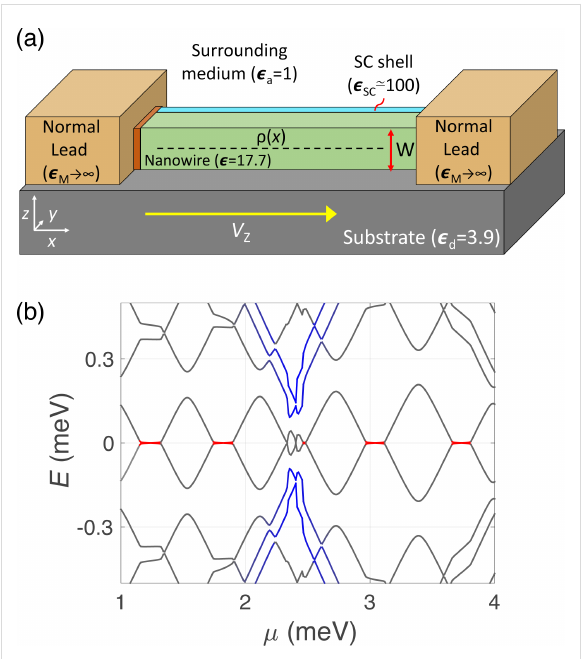
Figure 1: (a) Schematic representation of the setup analyzed in the present work. A nanowire of rectangular cross section (green) lying on an insulating substrate (grey) and in contact to a thin metallic layer in one of its faces (light blue), corresponding to the parent supercon- ductor, and two normal metal leads at its ends (orange) separated by tunnel barriers (brown). Typical values for the dielectric constants for each region are indicated. (b) Low-energy spectrum as a function of the chemical potential μ for a wire of thickness W = 100 nm and length L = 1 μ m. Other parameters are the spin–orbit coupling α = 20 nm·meV, the induced pairing energy Δ = 0.3 meV and the Zeeman energy V Z = 2 meV. Electrostatic environment-induced zero- energy pinned regions between Majorana oscillations are indicated in red. Quantum-dot levels (in blue), occurring at the edges of the wire due to the interaction with the bulk contacts, anticross with Majorana levels and remove their zero-energy